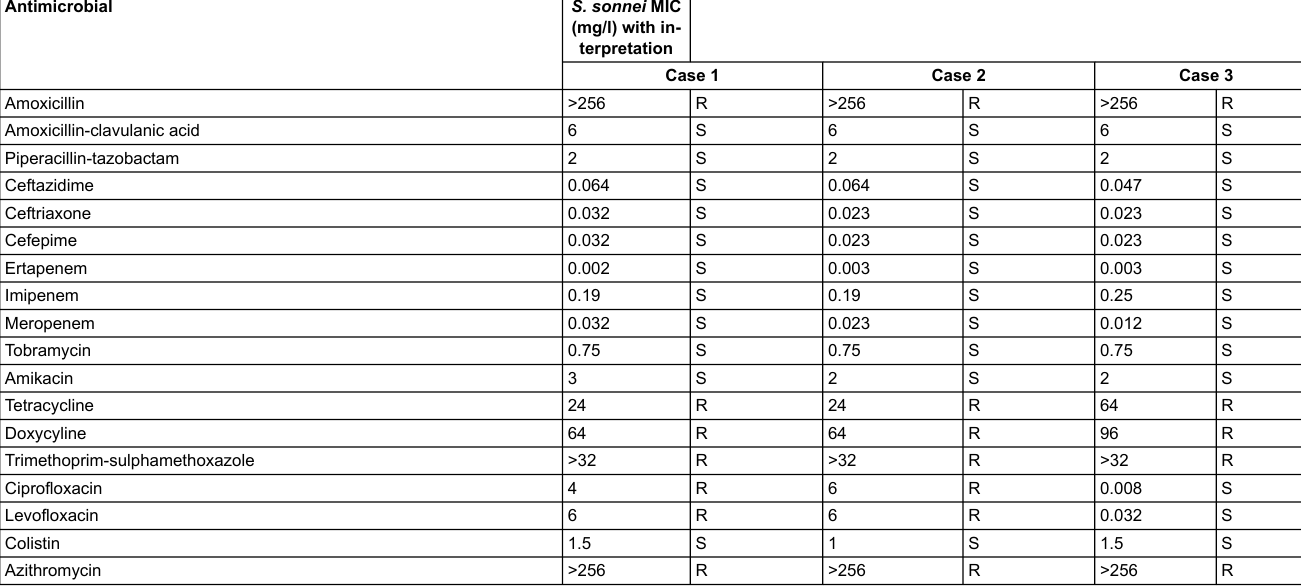
Table 1: Minimal inhibitory concentrations (MICs) of three S. sonnei isolates. Antimicrobial S. sonnei MIC